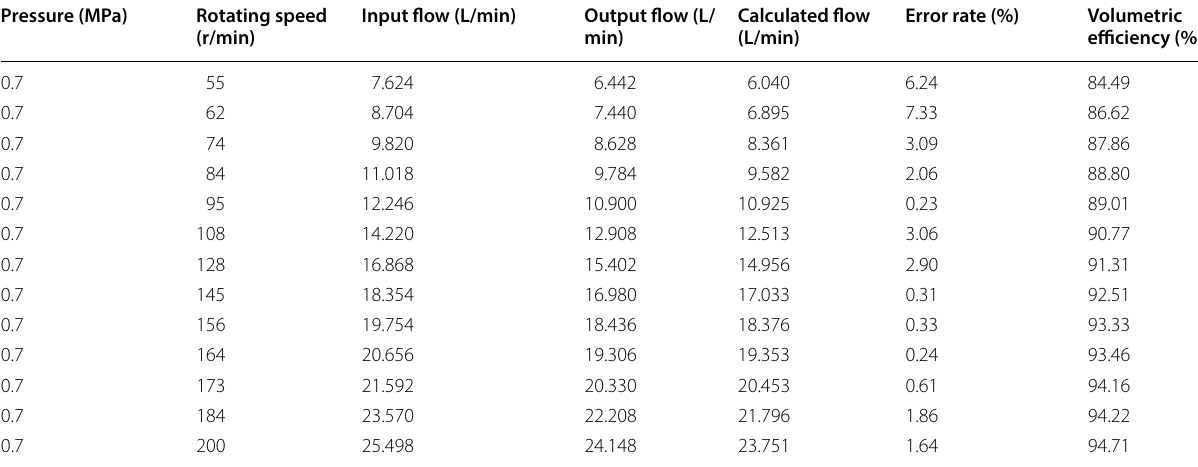
Table 4 Flow rate results of seawater hydraulic motor under no-load state Pressure